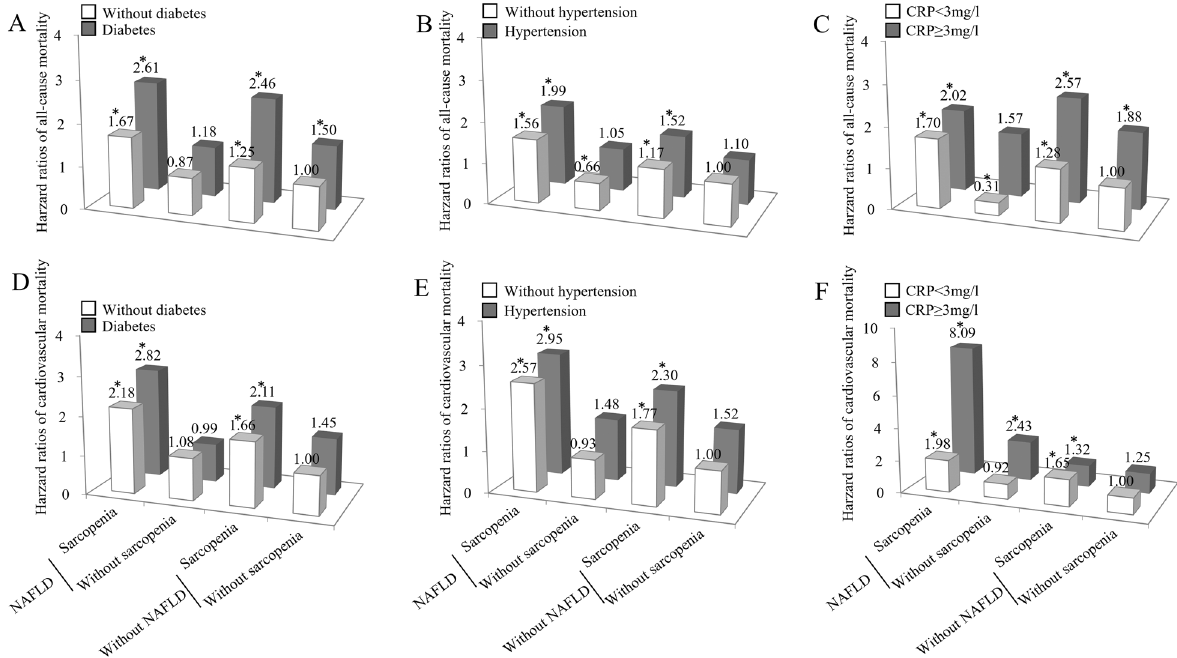
Figure 3. Joint effects of nonalcoholic fatty liver disease (NAFLD) and sarcopenia on all-cause (upper panel) and cardiovascular mortality (lower panel) after stratification for diabetes, hypertension, and inflammation status. *All-cause and cardiovascular mortality risks were significantly higher in sarcopenic subjects with NAFLD regardless of the status of diabetes, hypertension, and inflammation. Hazard ratios (95% confidence intervals) were adjusted for age, gender, race-ethnicity, education level, smoking and drinking status, body mass index, total cholesterol, triglyceride, HDL-cholesterol, and comorbid conditions such as stoke, coronary heart disease, and chronic obstructive pulmonary disease. Statistics and P values were showed in Supplementary Table